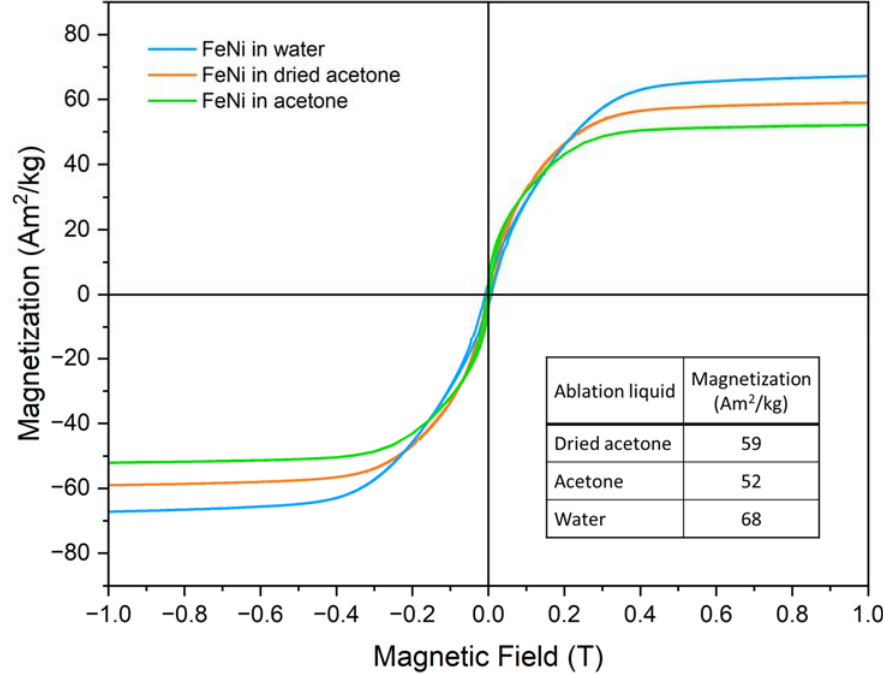
Figure 7. M(H) curves of FeNi nanoparticle powders from colloids prepared in different liquids at room temperature (300 K). FeNi in acetone data reproduced from [67].